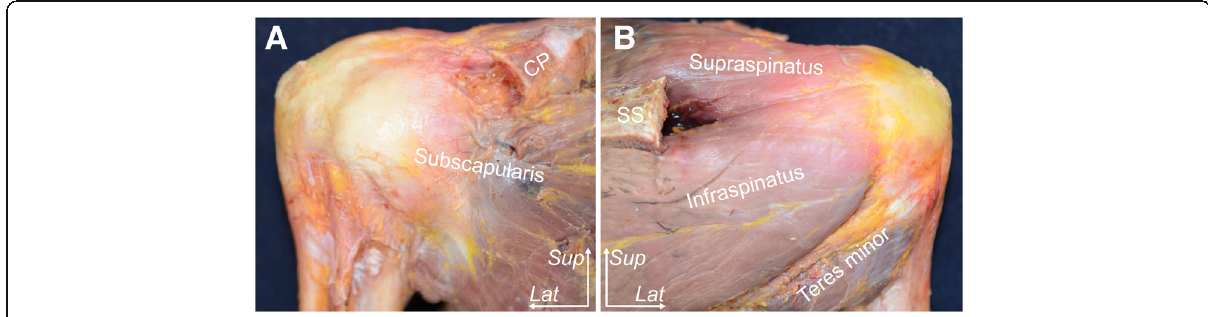
Fig. 1 Muscular and tendinous structures of the subscapularis, supraspinatus, infraspinatus, and teres minor near their insertions into the humerus (right shoulder, the acromion and coracoid process has been removed). a Anterior aspect of the shoulder. b Posterior aspect of the shoulder. CP, coracoid process; SS, scapula spine; Lat , lateral; Sup ,